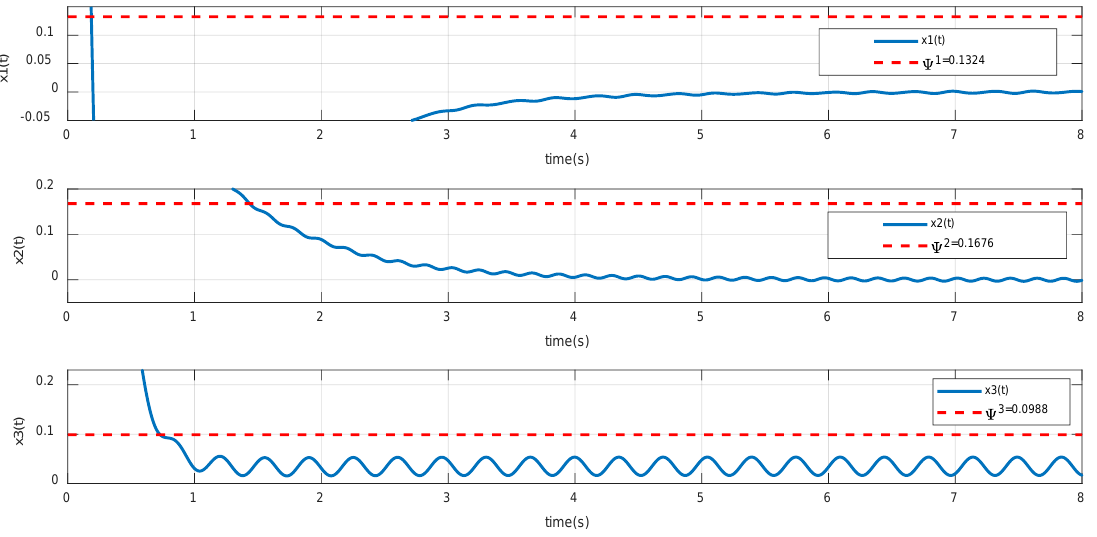
Figure 6. Zoom the dynamics of x 1 ( t ) , x 2 ( t ) , x 3 ( t ) from Figure 5.